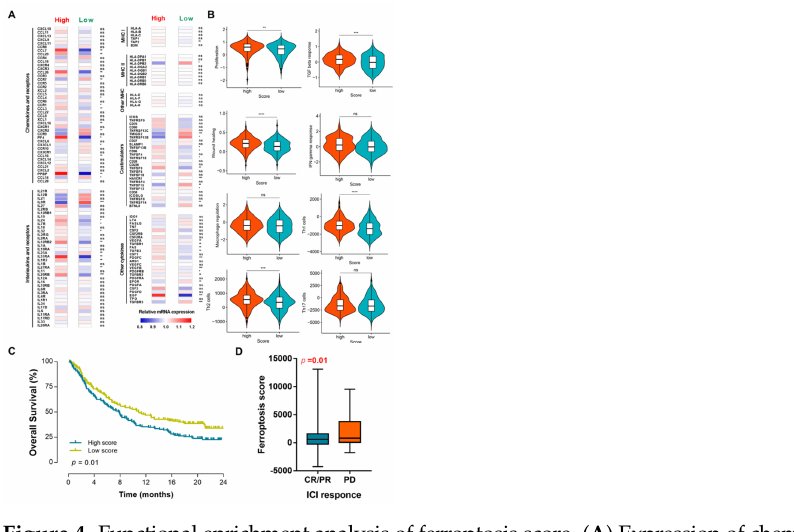
Figure 4. Functional enrichment analysis of ferroptosis score. ( A ) Expression of chemokines, interleukins, interferons, MHC molecules, costimulators, coinhibitors, and other important cytokines and their receptors in ccRCC from different subclusters. ( B ) Different values for vital immune characteristics in different subclusters. ( C ) Kaplan–Meier survival analysis of OS stratified by ferroptosis score in the IMvigor210 cohort treated with ICI. ( D ) Comparison of ferroptosis scores between BCa patients with different reactions to ICI treatment. OS, overall survival; BCa, bladder cancer; ICI, immune checkpoint inhibitor; CR, complete response; PR, partial response; PD, progressive disease. *, p < 0.05; **, p < 0.01; ***, p < 0.001; ****, p < 0.0001; ns, not significant.